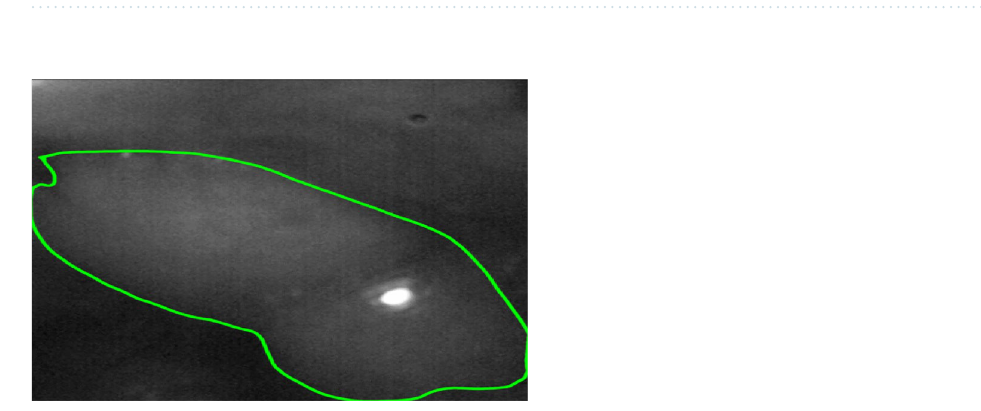
Figure 4. Example of multispectral image for the different wavelength bands. An example for the labelling of this multispectral image is shown in Fig. 2.